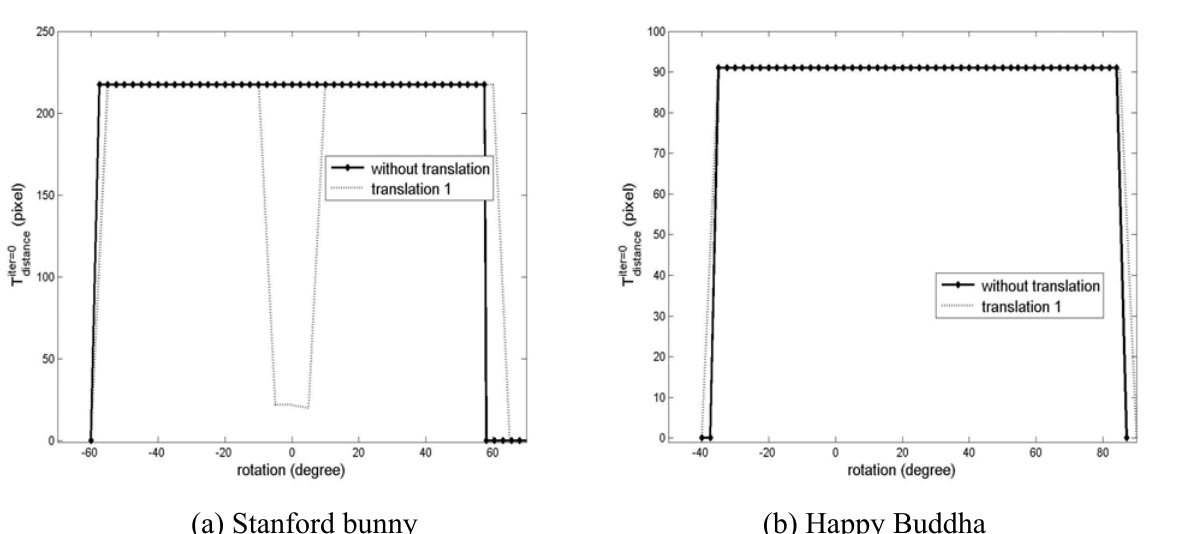
0  iter T , for the registration tests of the normal